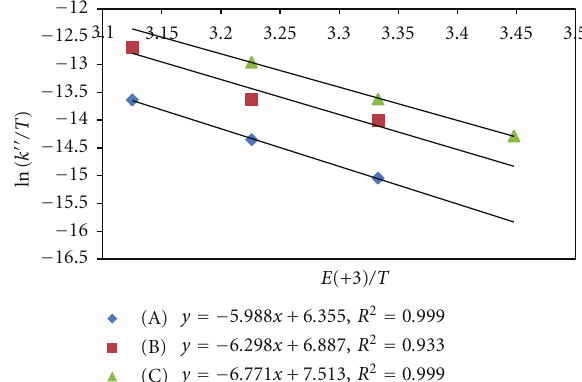
Figure 3: Eyring’s plot of ln( k (cid:5)(cid:5) /T ) versus 1 /T (uncatalyzed reac- tion). (A) Acetone (B) EMK (C)